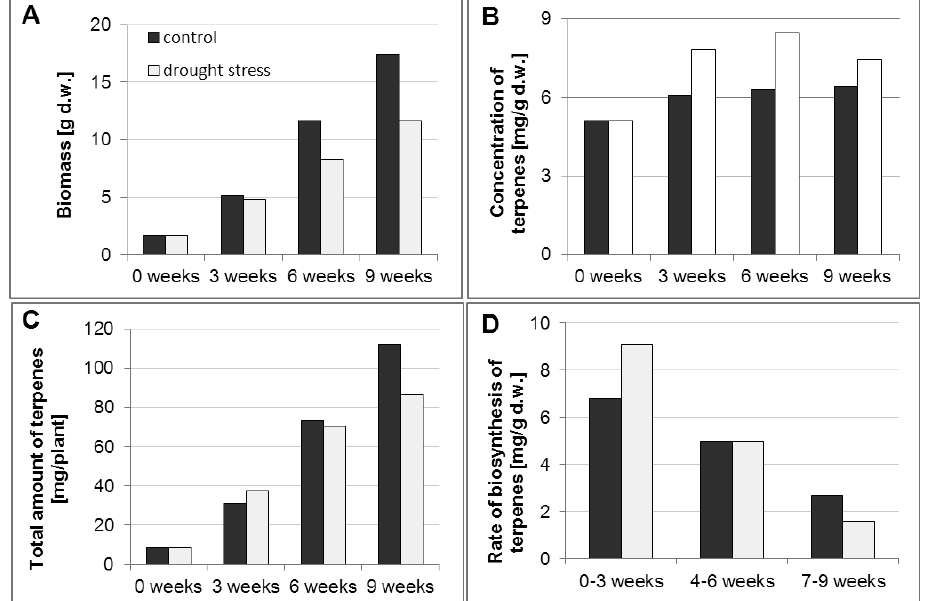
Fig. 1: Biomass (A), concentration of terpenes (B) total amounts of terpenes (C) and rates of biosynthesis of terpenes (D) in well-watered and drought stressed thyme